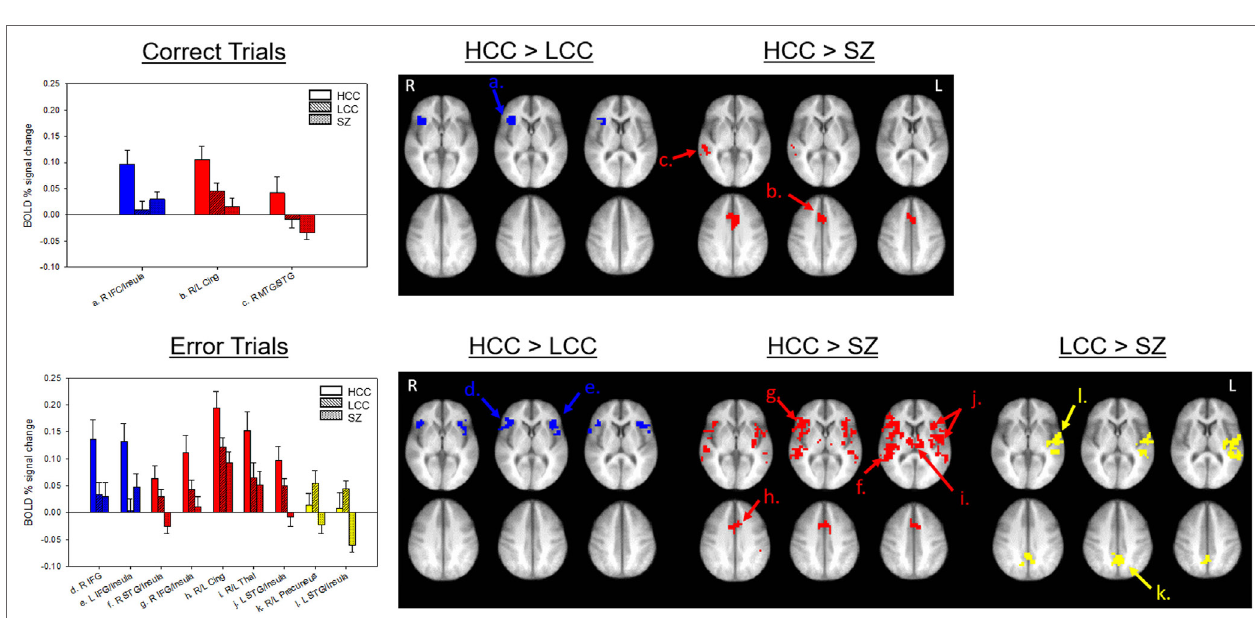
FigUre 3 | Antisaccade activation for correct and error trials. Maps show activation as measured by BOLD percent signal change for correct trials (top) and error trials (bottom) for each of the three groups (HCC, LCC, SZ). Warm colors indicate positive activation during correct and error trials, cool colors indicate task-induced suppression during correct and error trials. Activations are shown on an anatomical image averaged across all subjects in Talairach space ( z = 0 to z = 44) in radiological orientation (right side shown on the left). HCC, high cognitive control group; LCC, low cognitive control group; SZ, schizophrenia group.